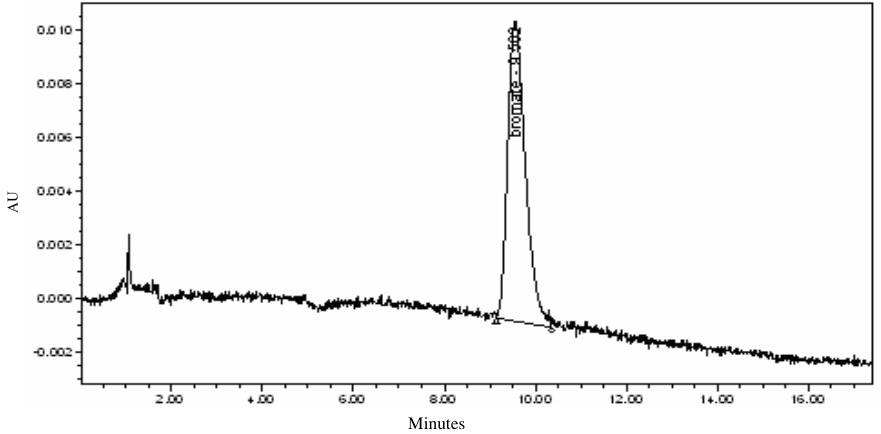
Figure 7. Chromatogram of bottled water (Sample No.3), chromatographic conditions are listed under experimental conditions